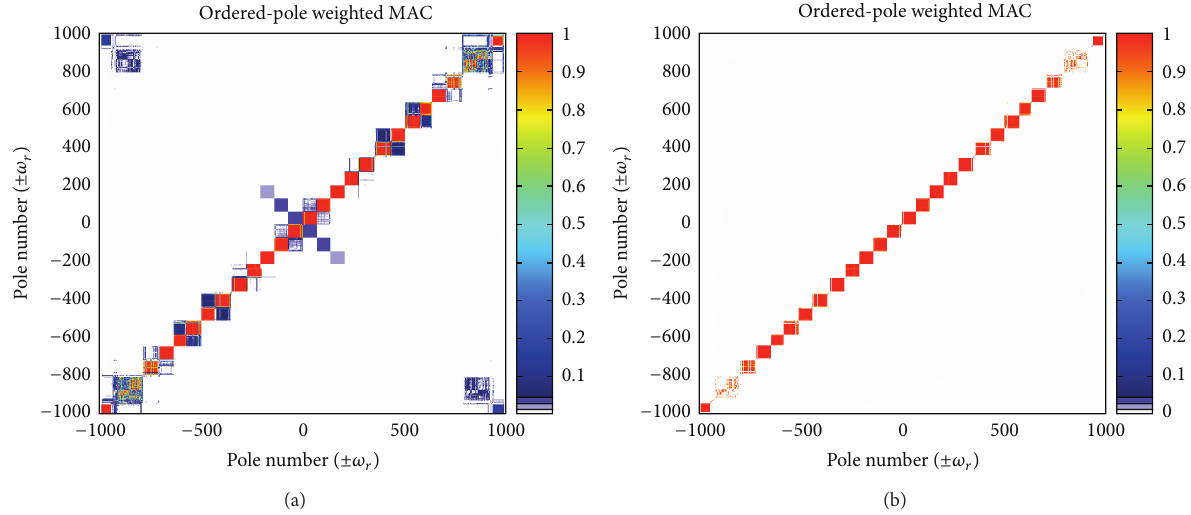
Figure 5: Pole-weighted MAC of all consistency diagram solutions, before and after threshold